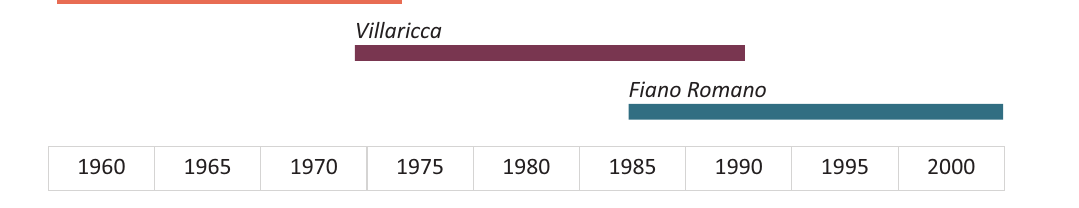
Figure 1. Sequence of suburbanization phases in the three target